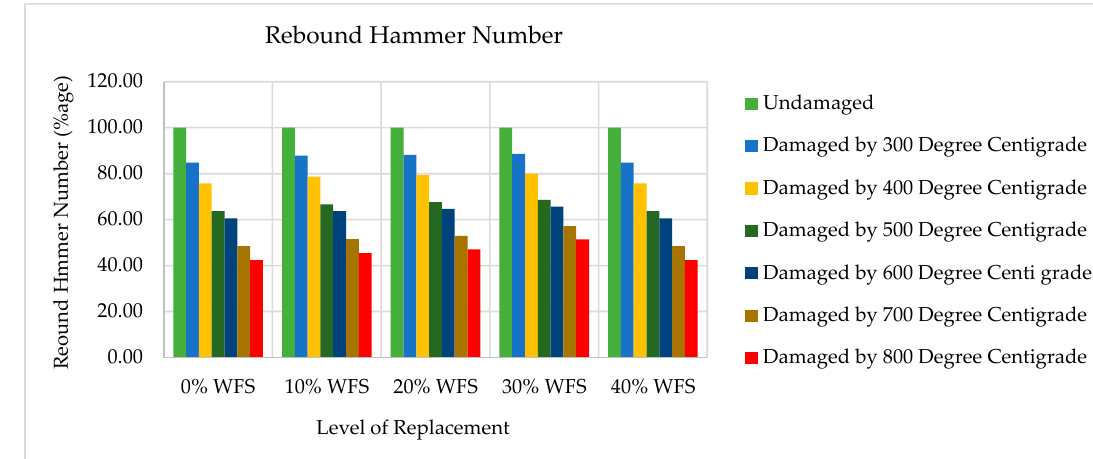
Figure 12. Variation in rebound hammer number (RHN) with elevated temperatures.